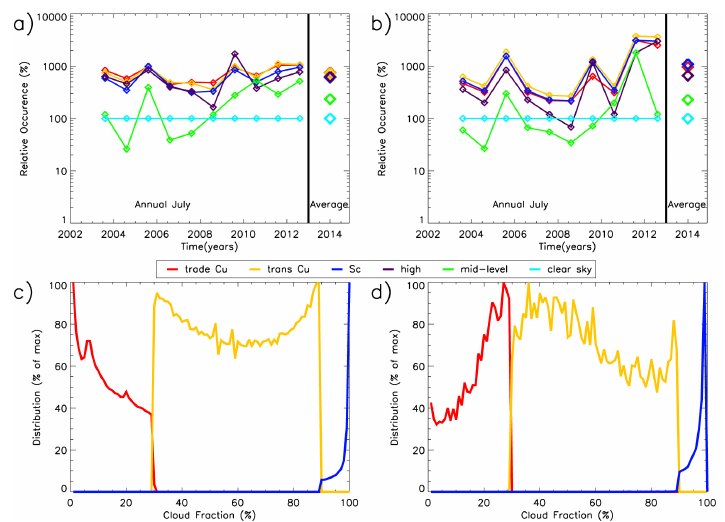
Fig. 2. Annual and average occurrence of cloud types relative to clear sky (panels a and b ) and cloud fraction (panels c and d ) for the entire 310-day data set. The left column is for the AIRS/MODIS observations, and the right is for ERA-Interim.